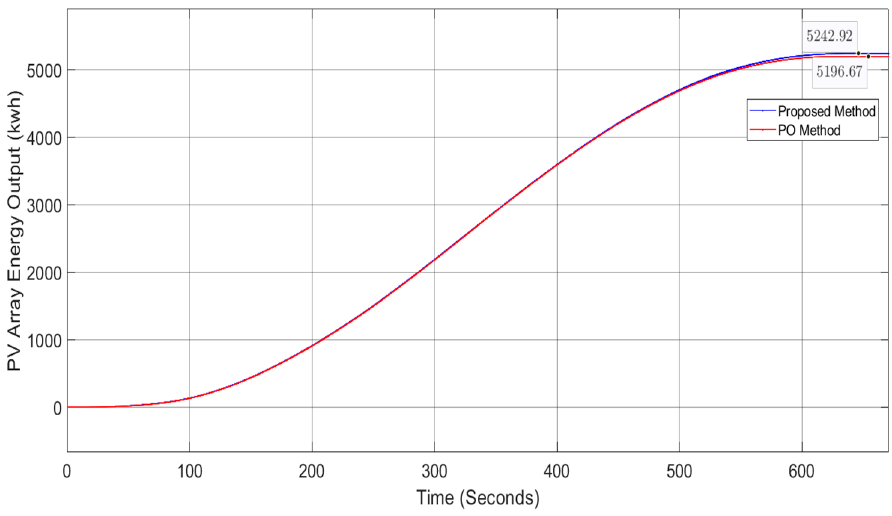
Figure 7. Total energy of the proposed method and the PO method for a clear day.